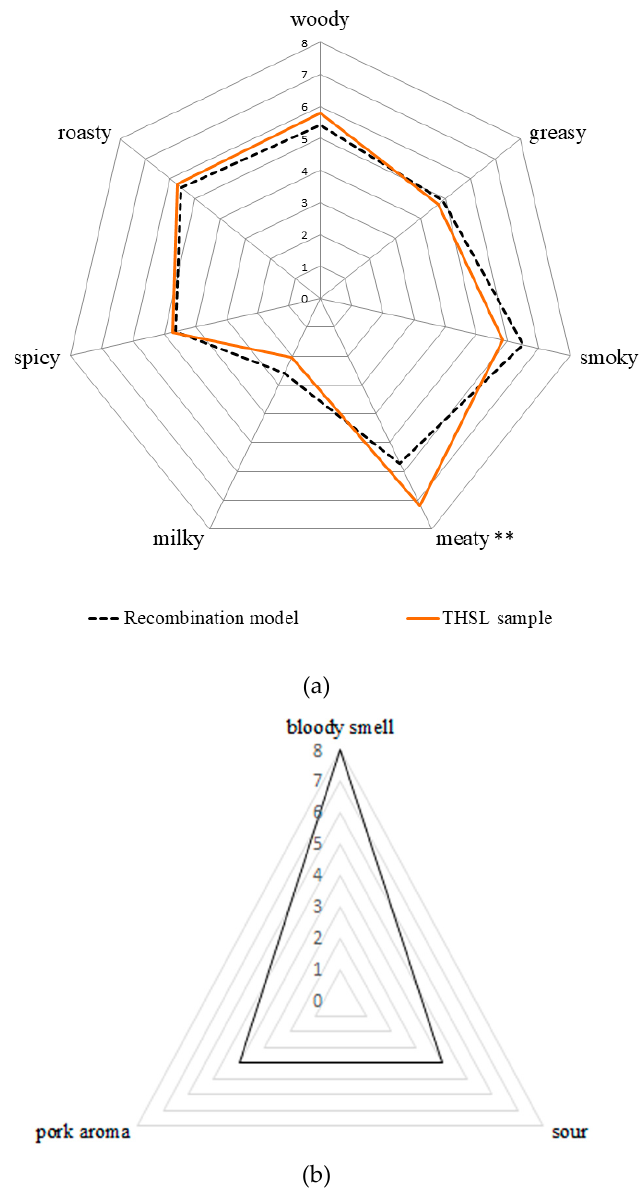
Figure 2. Quantitative descriptive analysis results of the traditional Hunan smoke-cured pork leg (THSL), along with its aroma recombination model ( a ) and the raw material of the pork leg ( b ). **, the significance at p < 0.01.